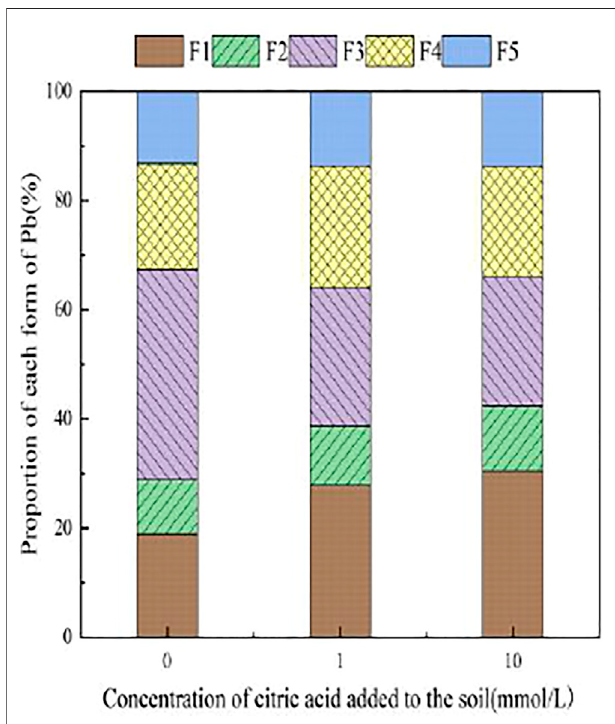
FIGURE 4| Distribution of Pb form in soil after adding citric acid and Pb- 200 soil after adding citric acid.